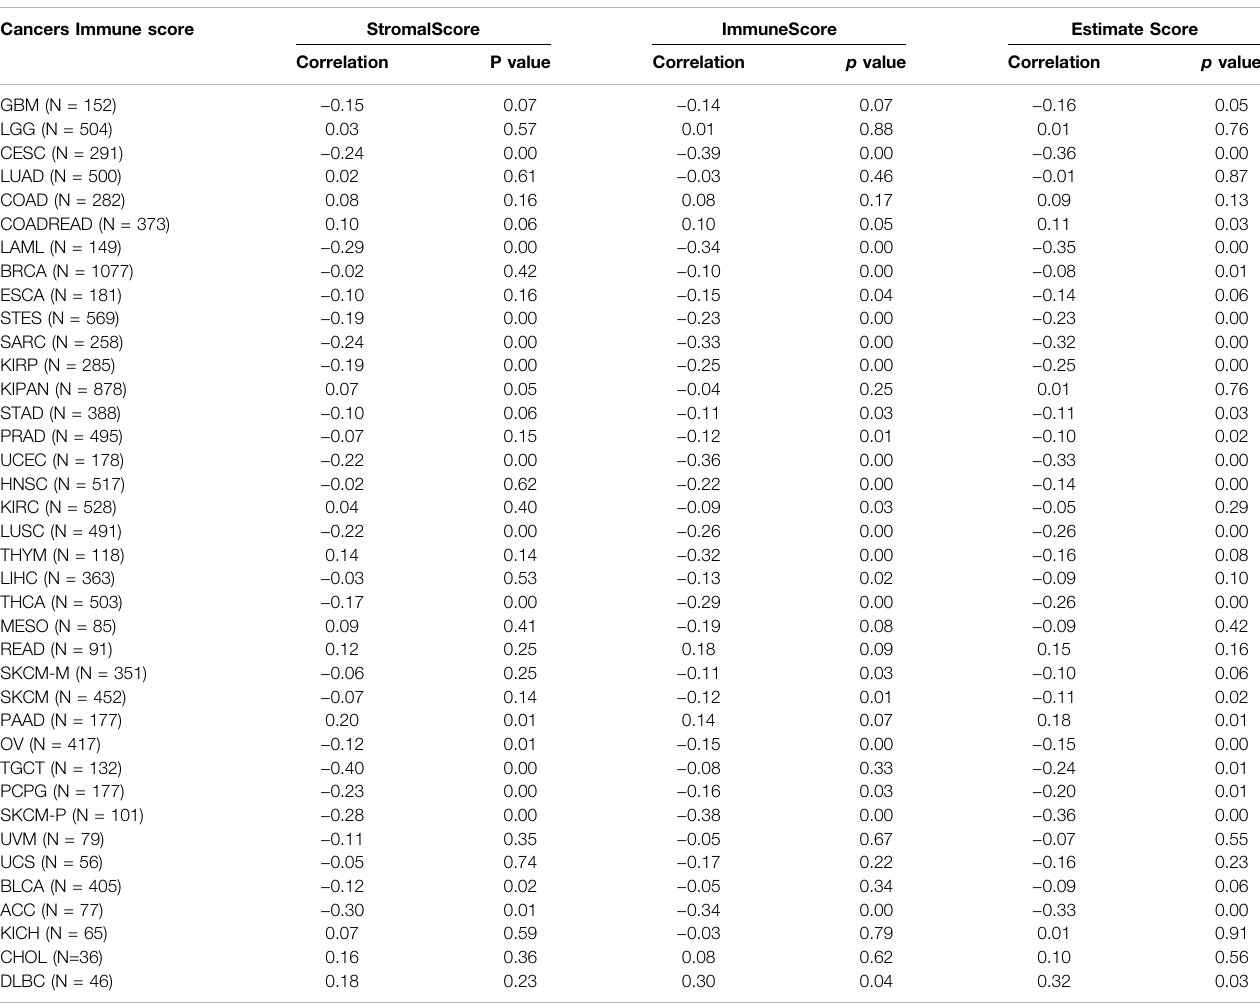
TABLE 1 | The relationship between the USP45 gene expression and immune score. Cancers Immune score